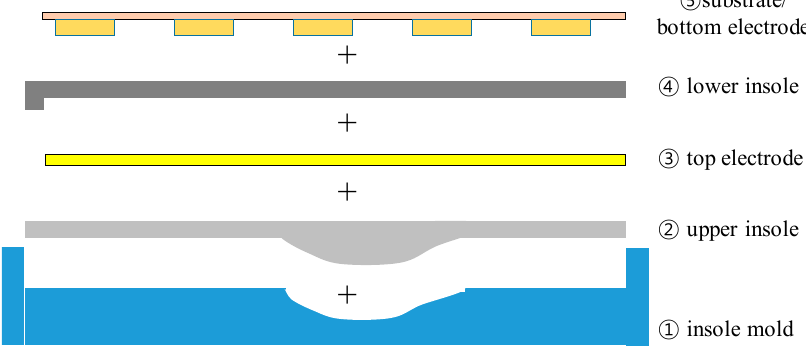
Figure 3. Insole fabrication sequence.